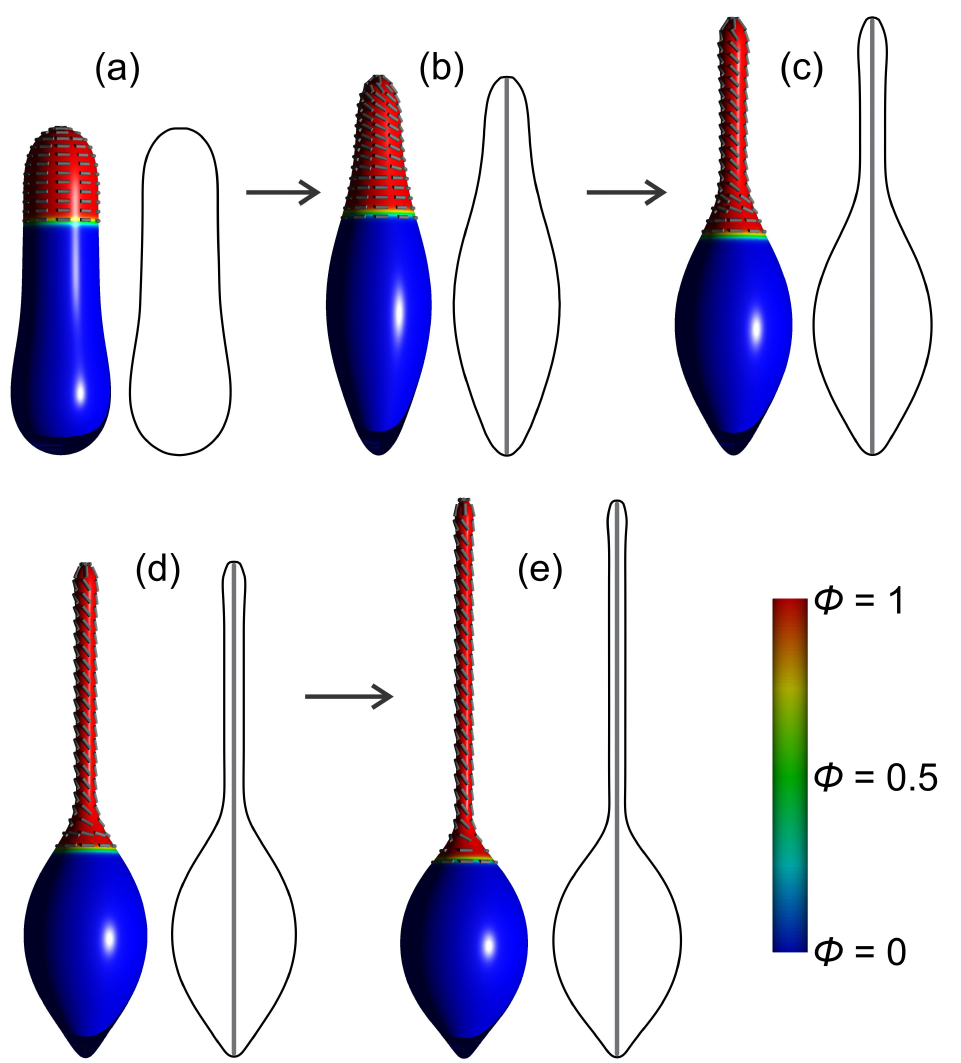
Figure 25. Equilibrium closed membrane shapes calculated for different lengths of the cytoskeleton rod-like structure inside the membrane (schematically shown as a grey rod inside the profile curve for each shape). Membrane contains a fixed value of average relative area density (concentration) of anisotropic rod-like BAR domains φ ave = 0.25. The red color ( φ = 1) represents the highest possible local relative area density (concentration) of BAR domains, while the blue color ( φ = 0) represents the surface patches with almost no BAR domains. Grey lines on the protrusions denote the directions of the orientation of BARs. For simplicity reasons, the entropy of mixing of BAR domains was not taken into account. Shapes were calculated within the model introduced in Section 3.2 for the following values of model parameters: C 0 = 0, v = 0.70, C p = 3.0, K p L 0 /2 = k c